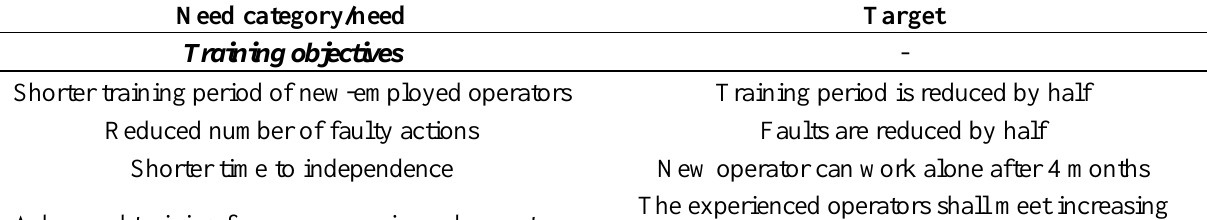
Table 1. First tier of training needs of plant operators 1